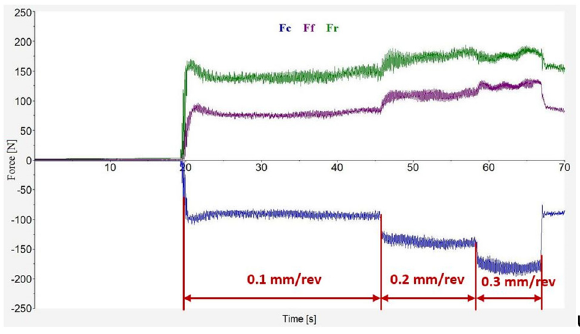
Figure 3: Fc, Ff, and Fr force diagrams in turning of GFRP